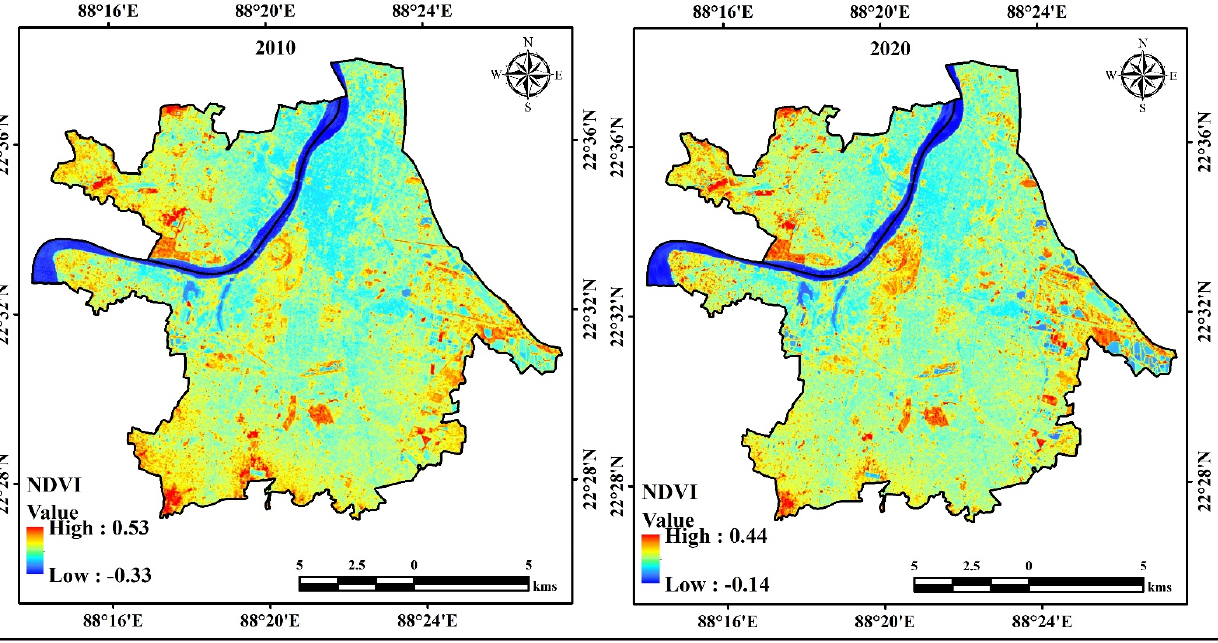
Figure 8. Normalized difference vegetation index (NDVI) variations in 2010 and 2020 for West Bengal (Kolkata and Howrah).